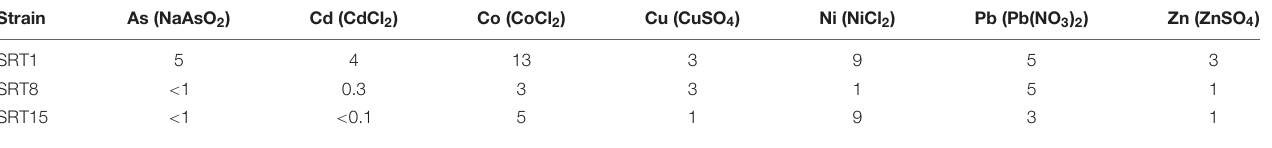
TABLE 3 | Maximum tolerable concentration (MTC) in mmoles L − 1 (mM) for each rhizobacteria strain and metal(loid) tested.